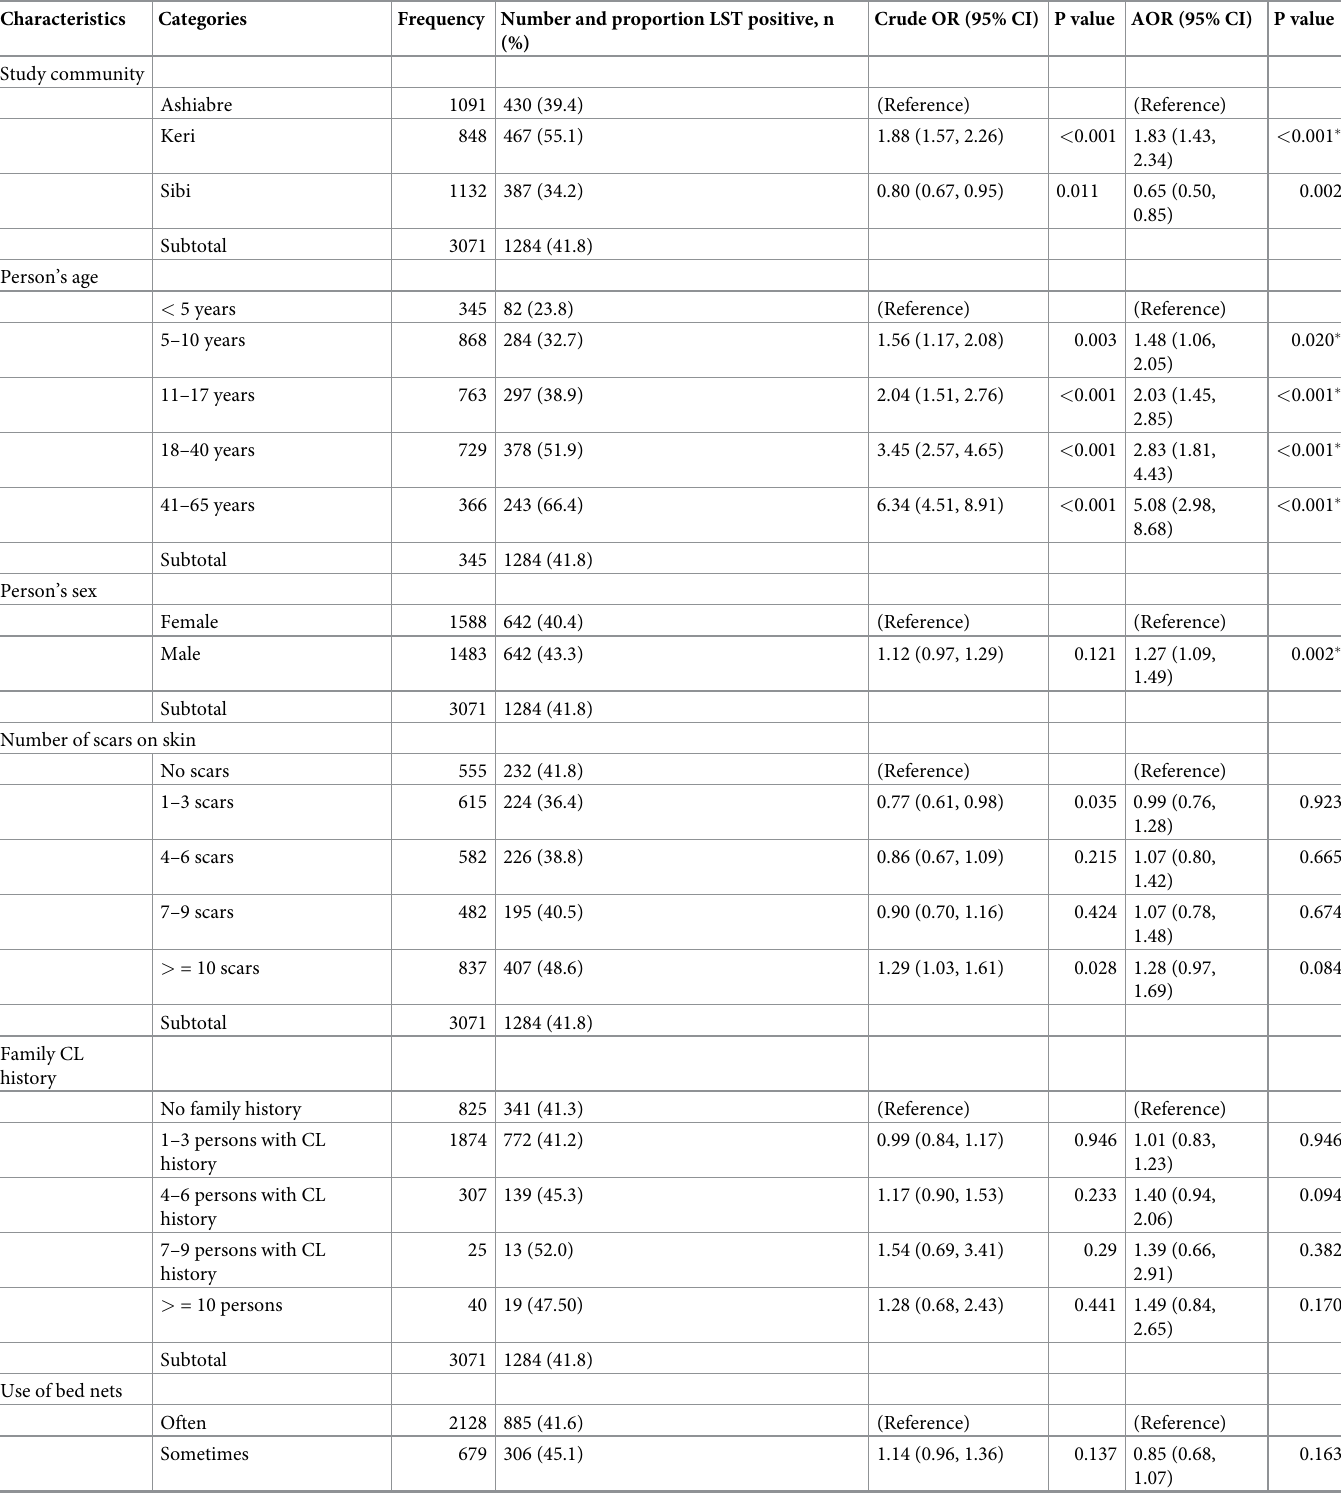
Table 4. Factors associated with LST positivity.